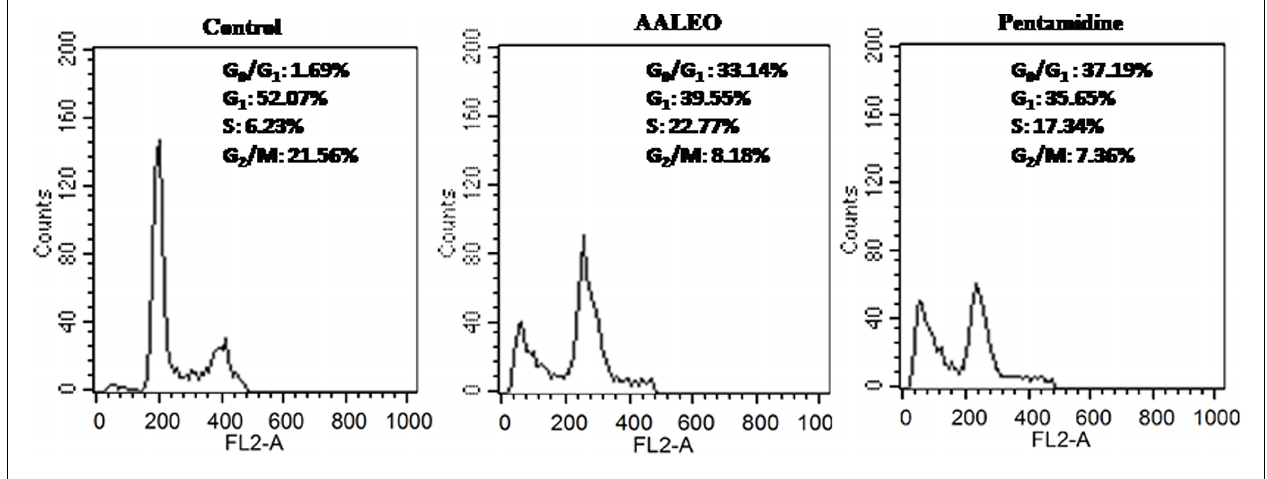
FIGURE 5 | Artemisia annua leaves induces cell cycle arrest in L. donovani promastigotes at sub-G 0 –G 1 phase. After treatment with AALEO and pentamidine (100 μ g ml − 1 ) for 72 h, the promastigotes were fixed in chilled methanol, probed with PI and the cells acquired using a